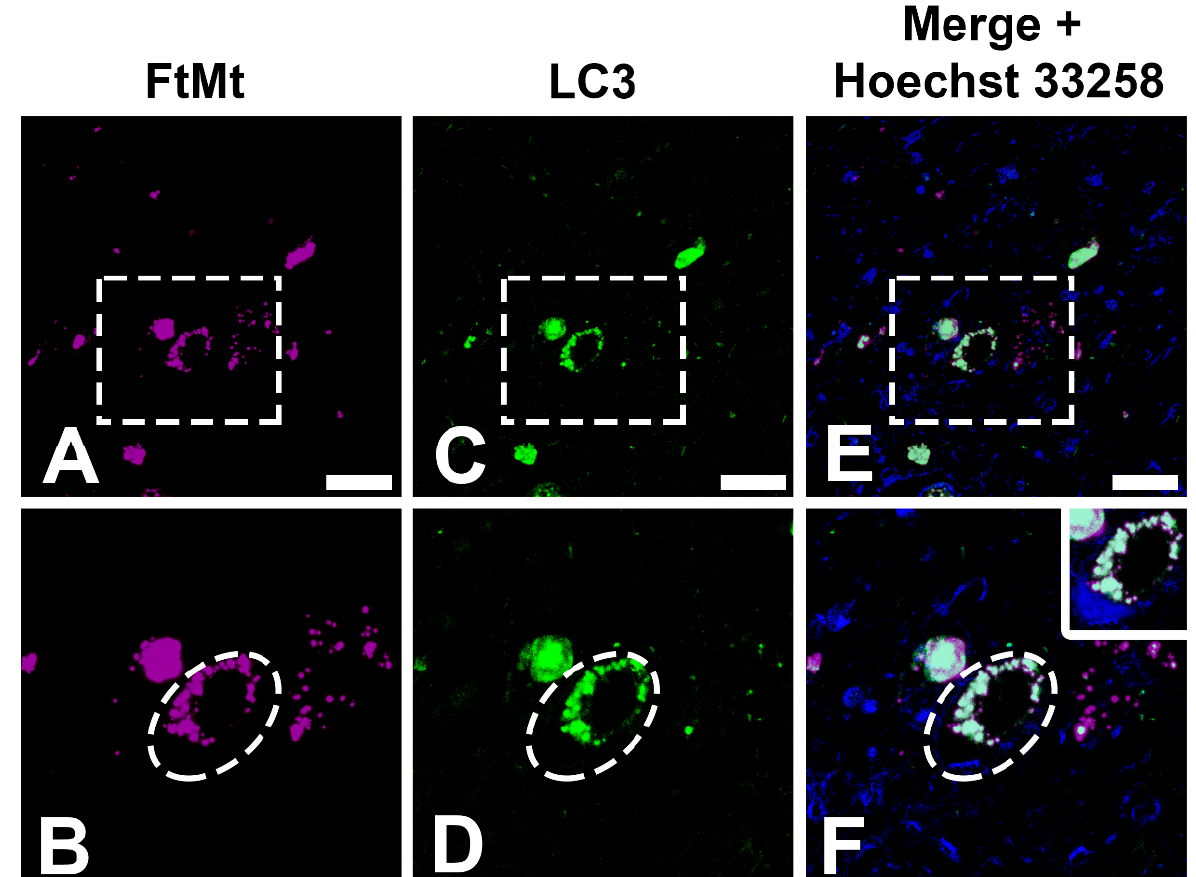
Figure 1 . FtMt and LC3 immunoreactivity and merged images of the two immunoreactive signals. Figure 1. FtMt and LC3 immunoreactivity and merged images of the two immunoreactive ( A,C,E ). Confocal images of FtMt, LC3, and merged signals of both immunoreactivities. There was an obvious colocalization between FtMt and LC3 immunoreactivity. ( B,D,F ). High-magnification image of the boxed area in A, C, and E, respectively. Drawn ellipses surrounding the neuron were the acquired size for rendering a 3D model. Nuclei stained with Hoechst 33258 are shown in the merged images. Panels ( F ) contain an additional inset with vivid nuclei staining to illustrate the boundaries of the cell nucleus (magnification is the same as the main panel). All scale bars: 20 µm.